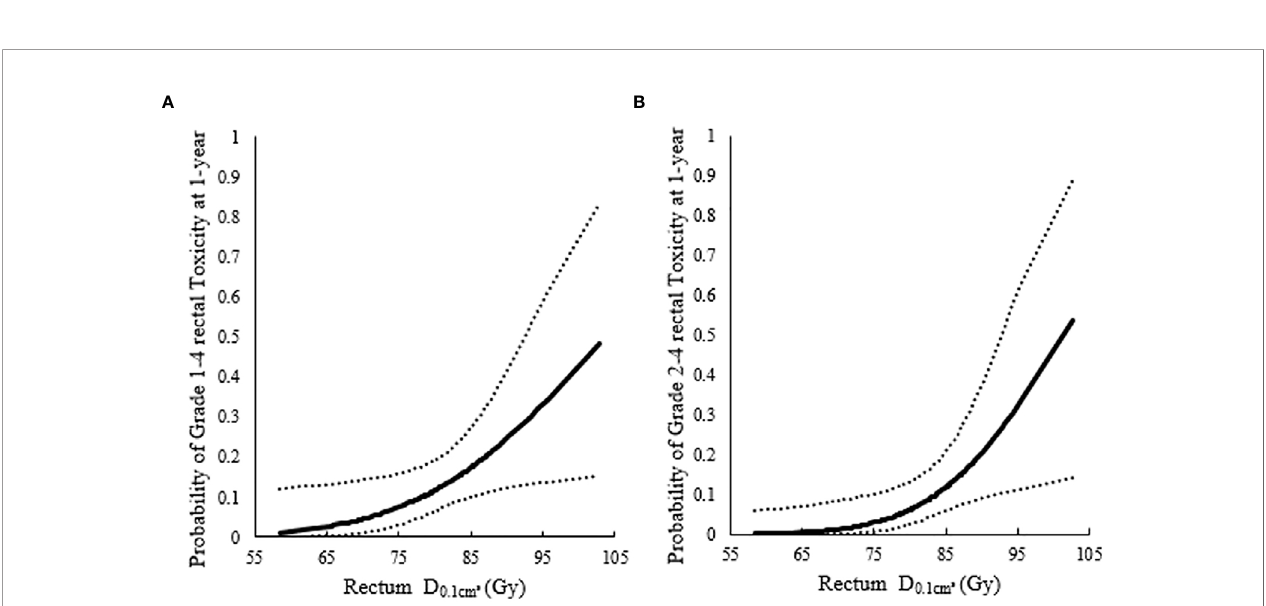
FIGURE 3 | Probit models between 1-year incidence of rectum morbidity and highlighted signi fi cant association of the D 0 : 1cm 3 for rectum. (A) Probit models between 1-year incidence of rectum morbidity with grade 1 – 4 and highlighted signi fi cant association of the D 0 : 1cm 3 for rectum; (B) Probit models between 1-year incidence of rectum morbidity with grade 2 – 4 and highlighted signi fi cant association of the D 0 : 1cm 3 for